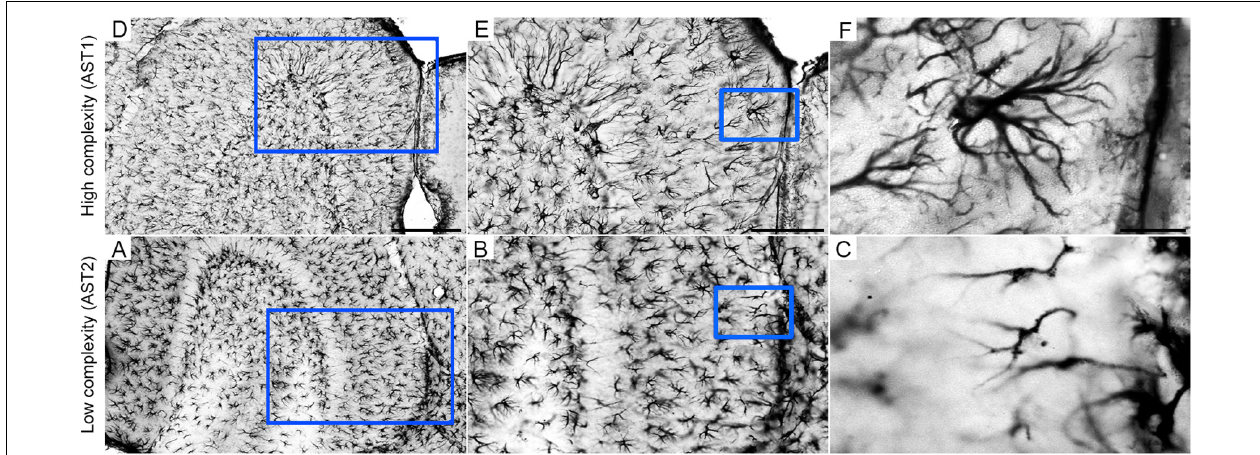
FIGURE 4 | Low (A,D) , middle (B,E) , and high (C,F) power photomicrographs of GFAP-immunolabeled astrocytes to illustrate high (AST1) and low (AST2) morphological complexities in the external one third of molecular layer of mouse dentate gyrus. Blue squares identify the anatomical region from where pictures of illustrated cells were taken. Scale bars: A/D = 250 urn; B/E = 125 urn; C/F = 25 urn. Astrocyte AST1 (high morphological complexity); AST2: Astrocyte AST2 (low morphological complexity).